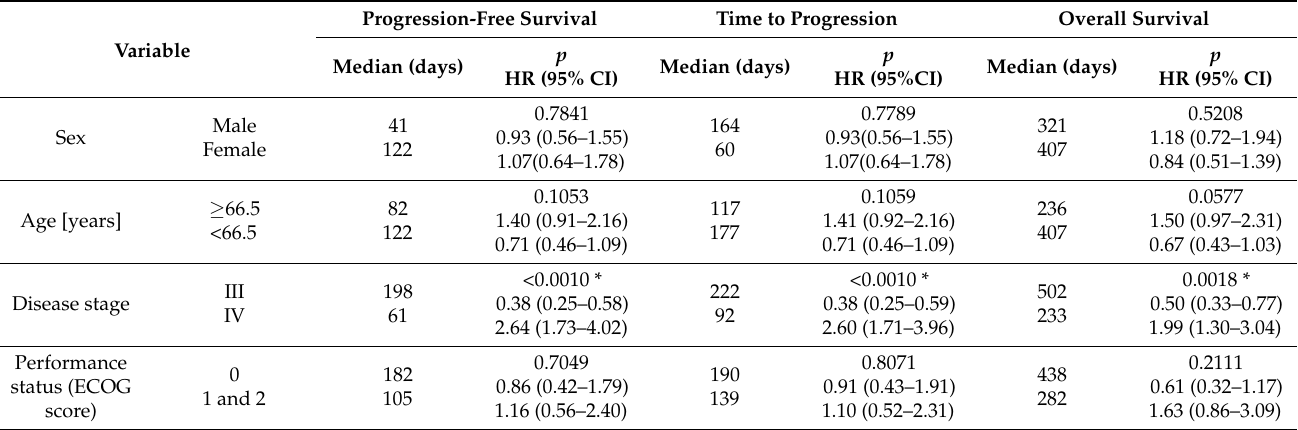
Figure 3. Kaplan–Meier curves representing probability of OS shortening depending on BIRC5 genotype. Table 3. Progression-free survival, time to progression, and overall survival according to demo- graphic, clinical, and genetic factors.